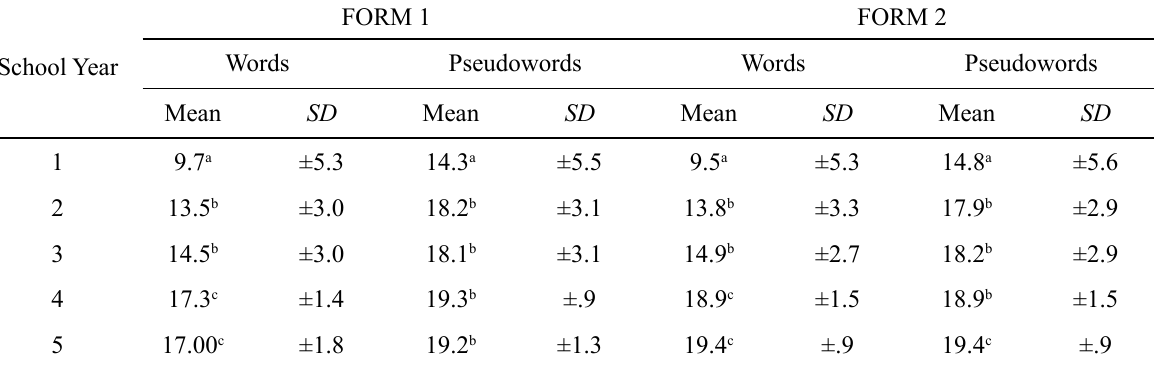
Mean and Standard Deviation (SD) of Correct Responses to Both Types of Stimuli (words and pseudowords) on the Word Subtest, by School Year